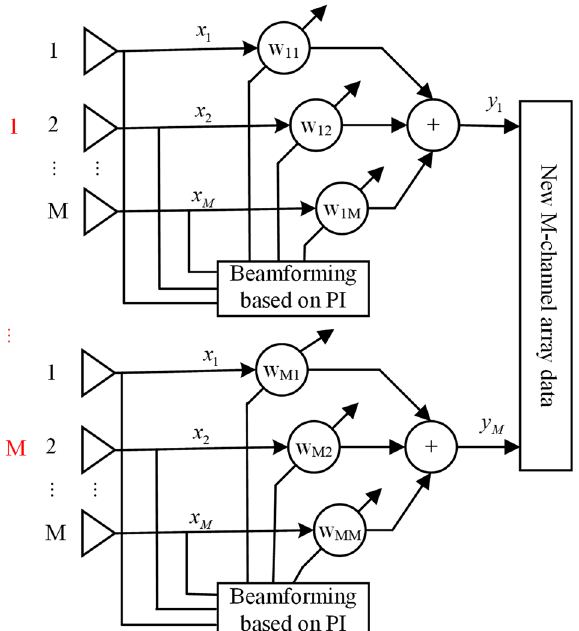
Fig. 2 Flow chart of the parallel PI